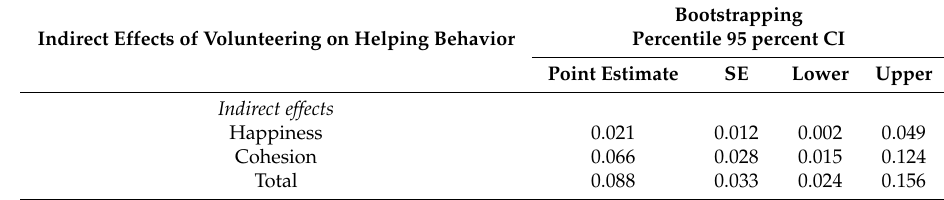
Table 6. Indirect effects of volunteering on helping